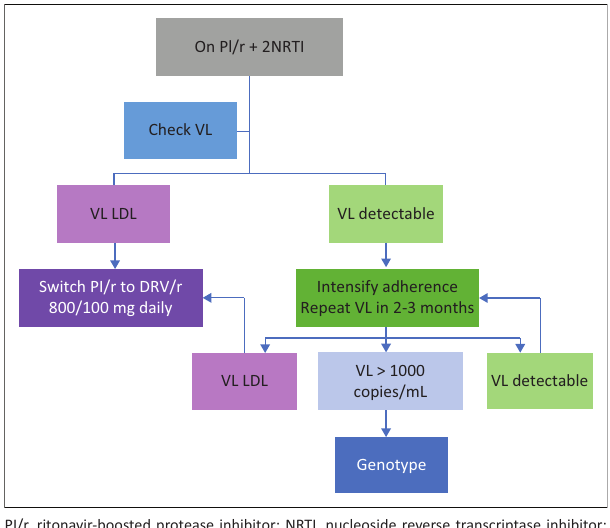
FIGURE 2: Patients on protease inhibitor-based second-line antiretroviral